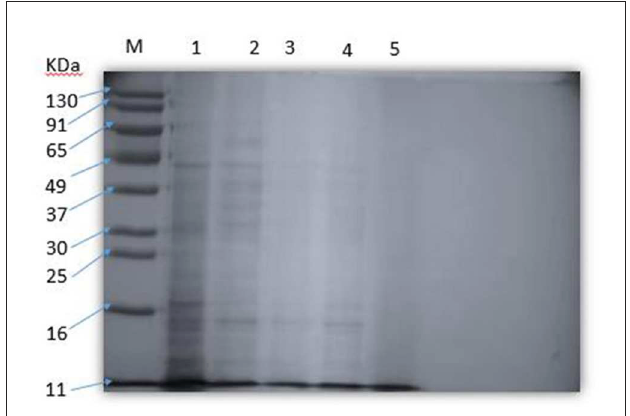
FIGURE6 The soluble protein of Salmonella enteritidis by SEDQS. M: Marker; 1: control group; 2: 1/4 MIC treatment group, 3: 1/2 MI treatment group C; 4: MIC treatment group; 5: 2 MIC treatment